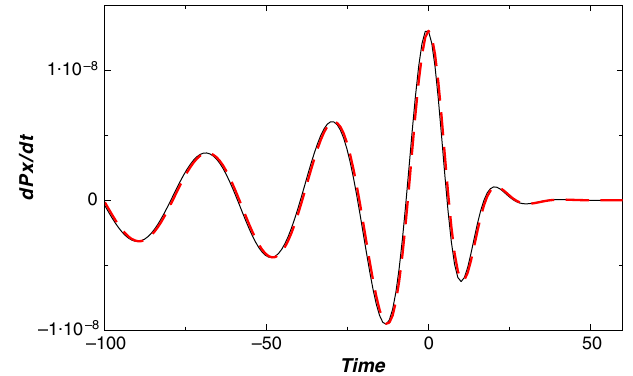
FIG. 5. Linear momentum flux as in Fig. 4 zoomed into the final plunge stage of the